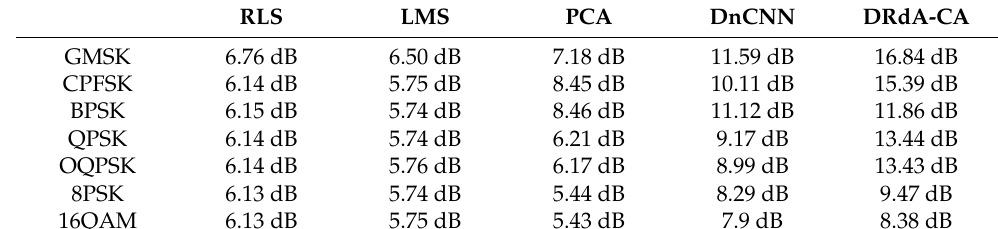
Table 4. Average value of SNR improvement under different denoising methods.